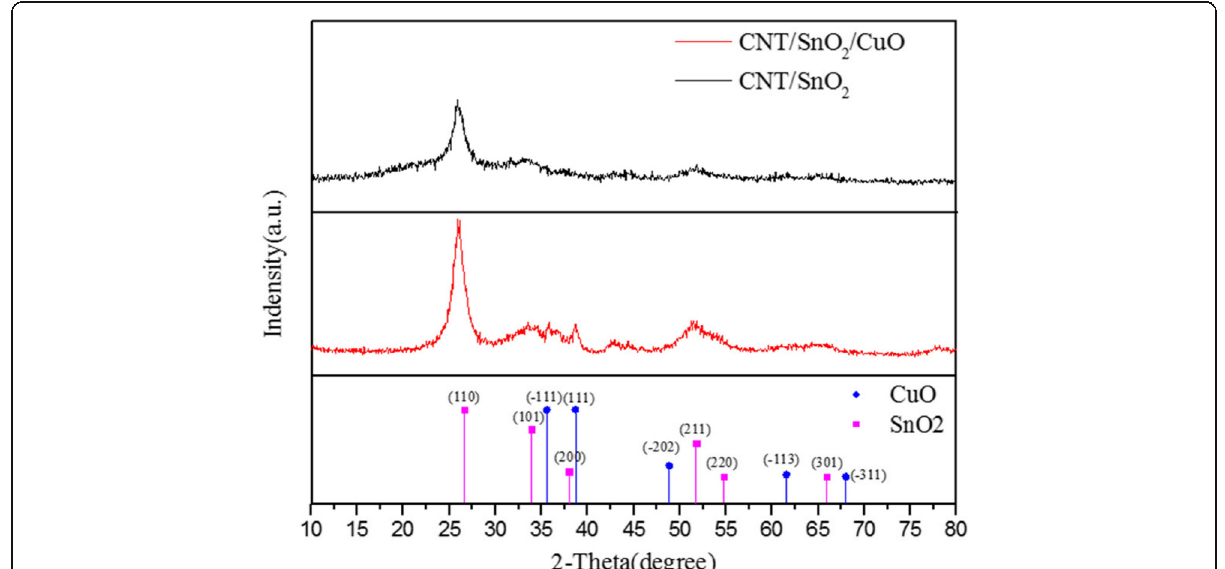
Fig. 4 XRD patterns of the CNTs/SnO 2 and CNTs/SnO 2 /CuO